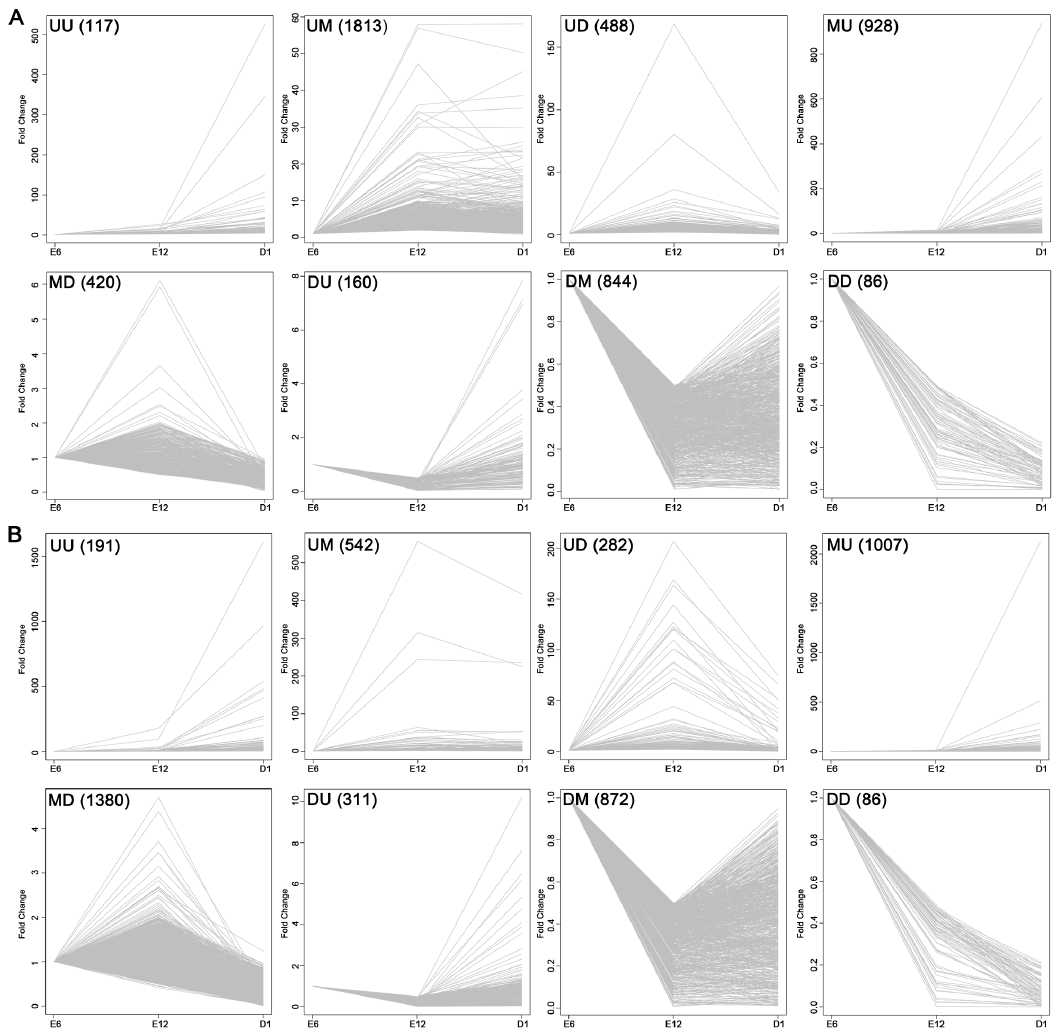
Figure 7. Development-dependent patterns of DEGs in the left gonad ( A ) and the right gonad ( B ). Data were obtained from the union of the DEGs between sequential developmental stages, with the younger developmental stage used as the denominator. Genes were grouped into Up (U; “upregulated” based on fold change (FC) >2 and false discovery rate (FDR) <0.05), Down (D; ‘downregulated’ based on FC > 0.5 and p -value < 0.05), or Maintain (M; “no change” based on 0.5 < FC < 2 or p -value > 0.05). The number shown in each box indicates the number of genes within the pattern.